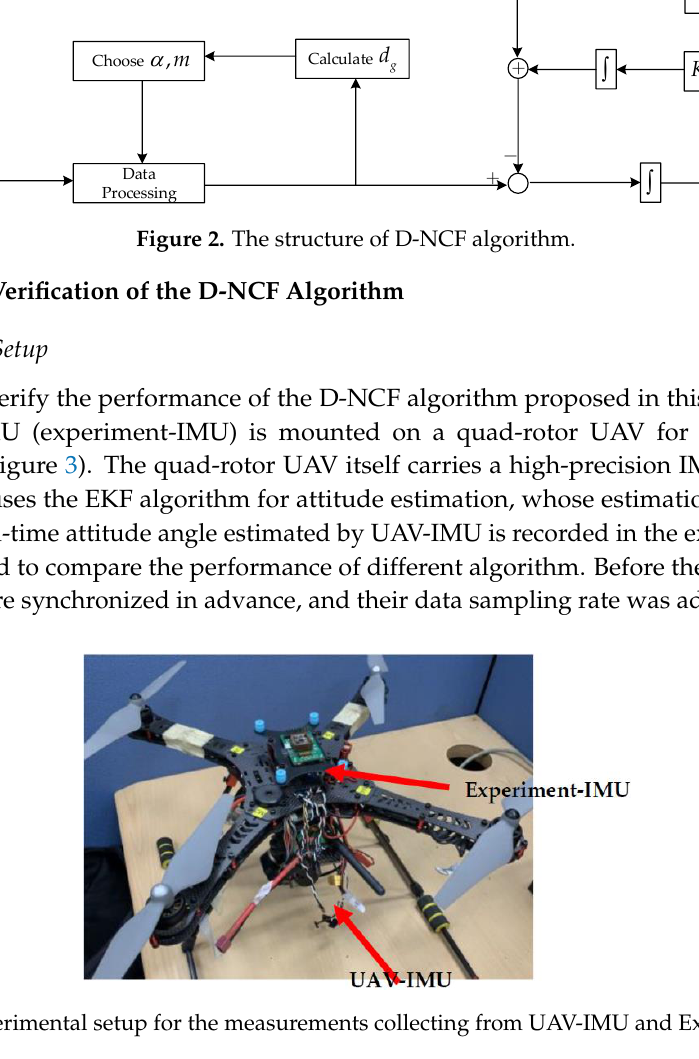
Table 1. Performance comparison of accelerometers, gyroscopes, and magnetometers contained in the experimental IMU and UAV-IMU.